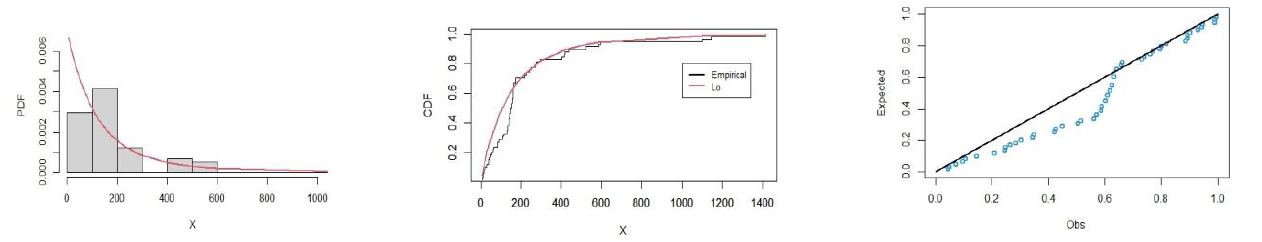
Figure 7. Estimated PDF, CDF, and PP plots of the Lo distribution for X .